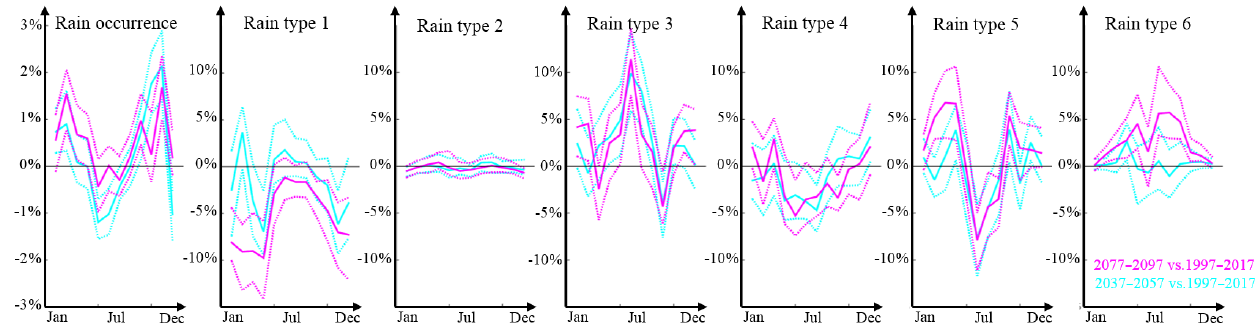
Figure 8. Changes in rain occurrence frequency (left panel) and rain type distribution conditional to the presence of rain (other panels) simulated using the stochastic rain type model developed in Sect. 3: 2037–2057 vs. 1997–2017 (light blue) and 2077–2097 vs. 1997– 2017 (purple). Continuous lines represent the median of the simulated ensembles (50 realizations), and dashed lines represent the Q 10 and Q 90